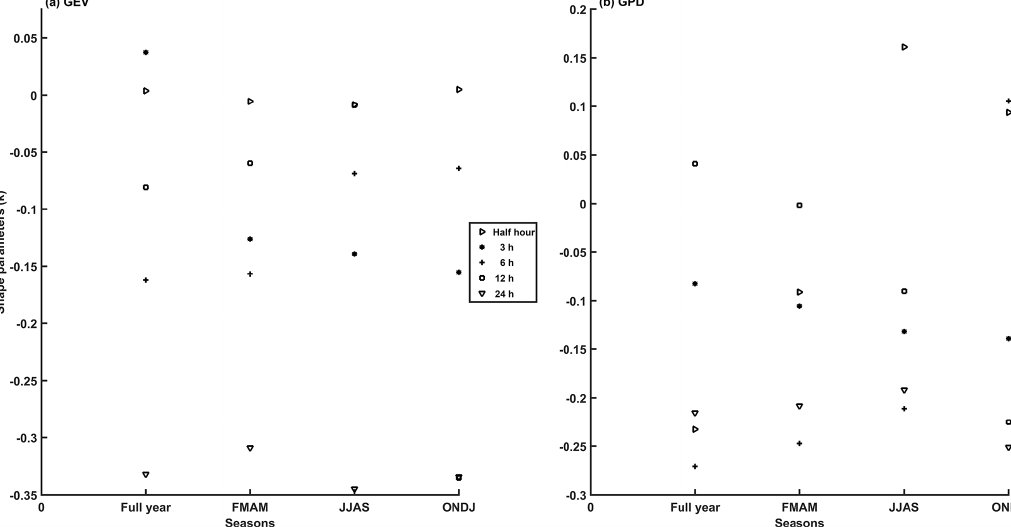
Figure 2. Estimated shape parameters for different seasonal data with different sampling intervals used in the (a) GEV and (b) GPD model. Table 3. Table showing different parameters and corresponding RMSEs of data and the estimated CDF used during each data series